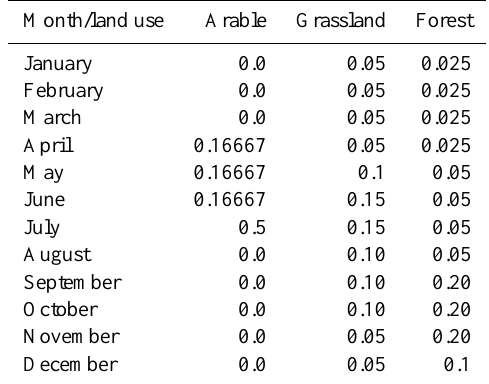
Month/land use Arable Grassland